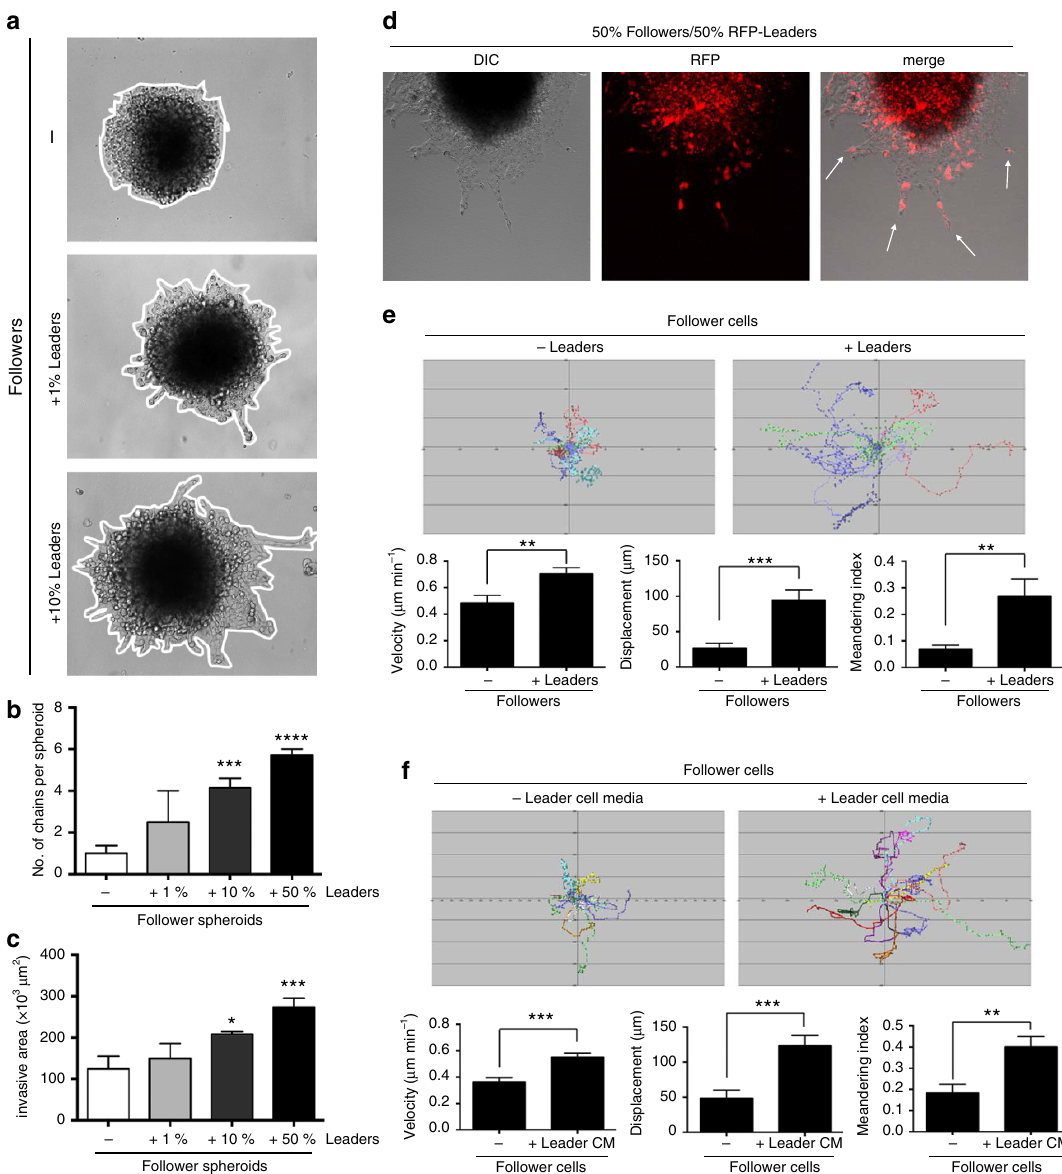
Figure 3 | Leader cells promote motility and invasion of follower cells through a soluble factor. ( a ) Spheroids were formed from follower cells either alone ( (cid:2) ) or in combination with increasing amounts of leader cells. ( b ) Quantification of the number of chains per spheroid in the experiment from a . n ¼ 6–7 spheroids. *** P o 0.001, **** P o 0.0001, using an ordinary one-way ANOVA with a Tukey’s multiple comparisons test. ( c ) Quantification of invasive area from the experiment in a . * P o 0.05, *** P o 0.001. ( d ) Spheroid invasion assay with RFP-expressing leader cells mixed with follower cells at a 50:50 ratio in a spheroid invasion assay. RFP-leader-positive chains are denoted by white arrows. ( e ) Follower cells were plated in 2D either alone or in co-culture with RFP-leader cells. Single follower cells were tracked over time. Cell track plots as well as quantification of these tracks are shown. n ¼ 10–13 cells. ** P o 0.01, *** P o 0.001, using a Student’s t -test. ( f ) Follower cells were plated in 2D in either their own or in LCM. Follower cell tracks are plotted and quantified below. n ¼ 15–17 cells. ** P o 0.01, *** P o 0.001 using a Student’s t -test. Error bars denote the